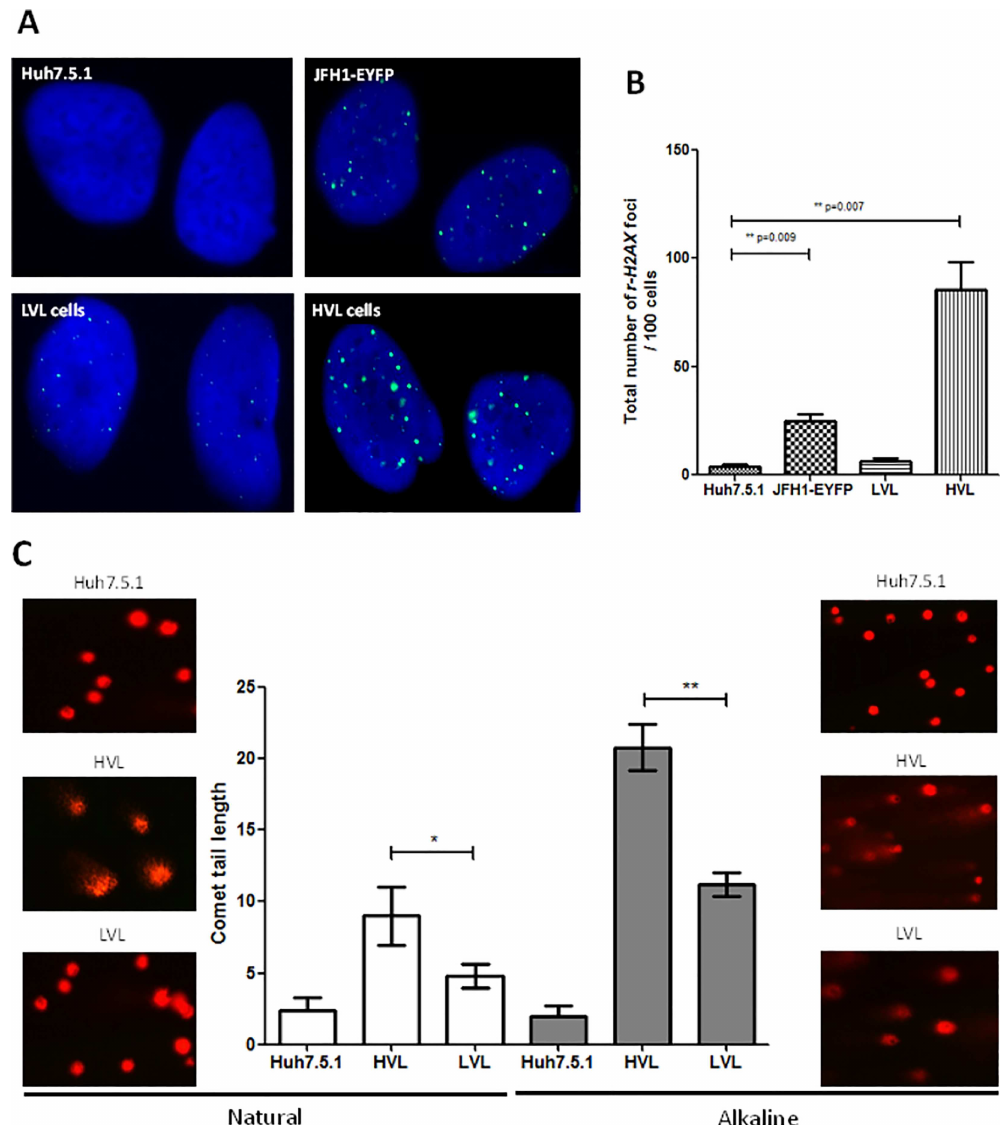
Huh7.5.1 cells, JFH1-EYFP-infected cells, LVL cells, and HVL cells. (B) The average number of γ -H2AX foci per 100 cells and the total count of 500 cells in three independent experiments. ** P < 0.01. (C) The comet tail was detected by single cell gel electrophoresis at neutral pH for DSBs and alkalinepH for SSBs/DSBs in HVL, LVL, and uninfected-Huh7.5.1 cells. * P < 0.05, ** P <